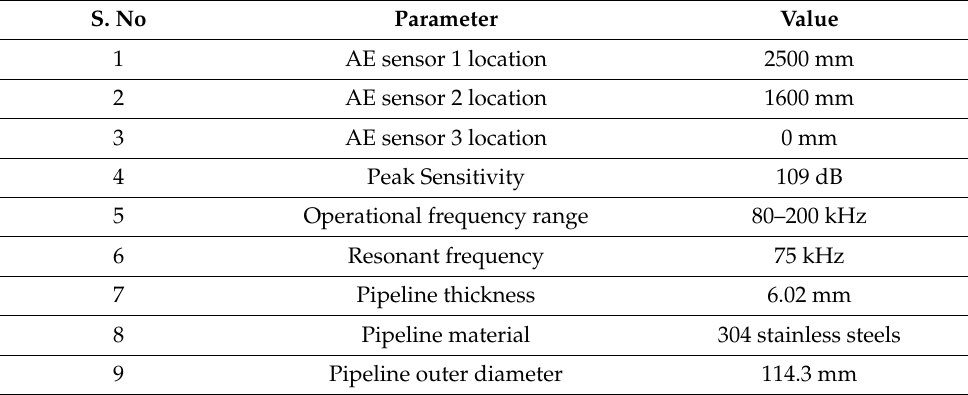
Table 1. Parameter for data